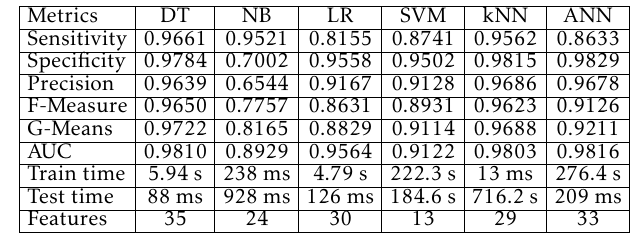
Table 28. Results of using GR-BFE algorithm on FUZZERS.